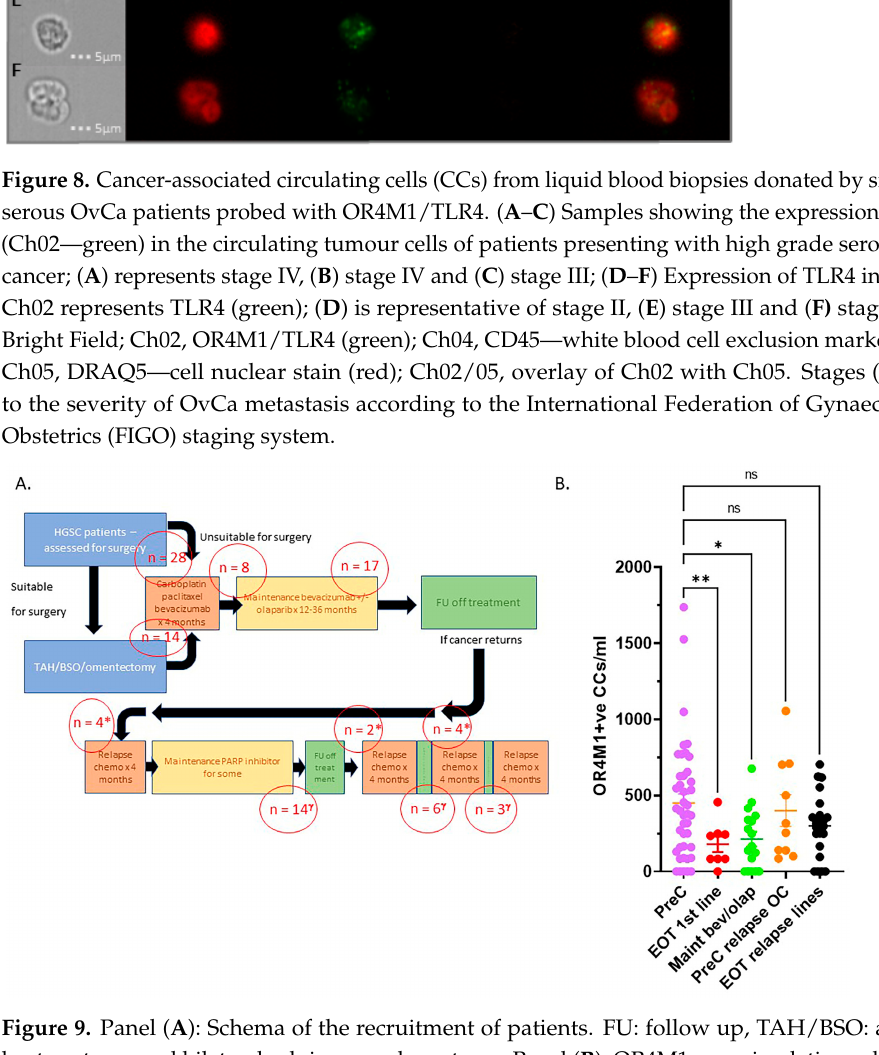
Figure 9. Panel ( A ): Schema of the recruitment of patients. FU: follow up, TAH/BSO: abdominal hysterectomy and bilateral salpingo-oophorectomy. Panel ( B ): OR4M1 + ve circulating cells decrease with chemotherapeutic treatment; 100 patients, representative of patients presenting with high grade serous ovarian cancer (HGSC) stages: I–IV: Pre-chemo (PreC, n = 42), end of first line chemotherapy (EOT 1st line, n = 8), maintenance bevacizumab +/ − olaparib (maint bev/olap, n = 17), pre-chemo for relapse OC (PreC relapse OC, n = 10), end of chemo for relapse OC (EOT relapse lines, n = 23). (Error bars: SEM; significance determined using ANOVA, * p = 0.012, ** p = 0.0069). CCs: cancer-associated circulating cells.